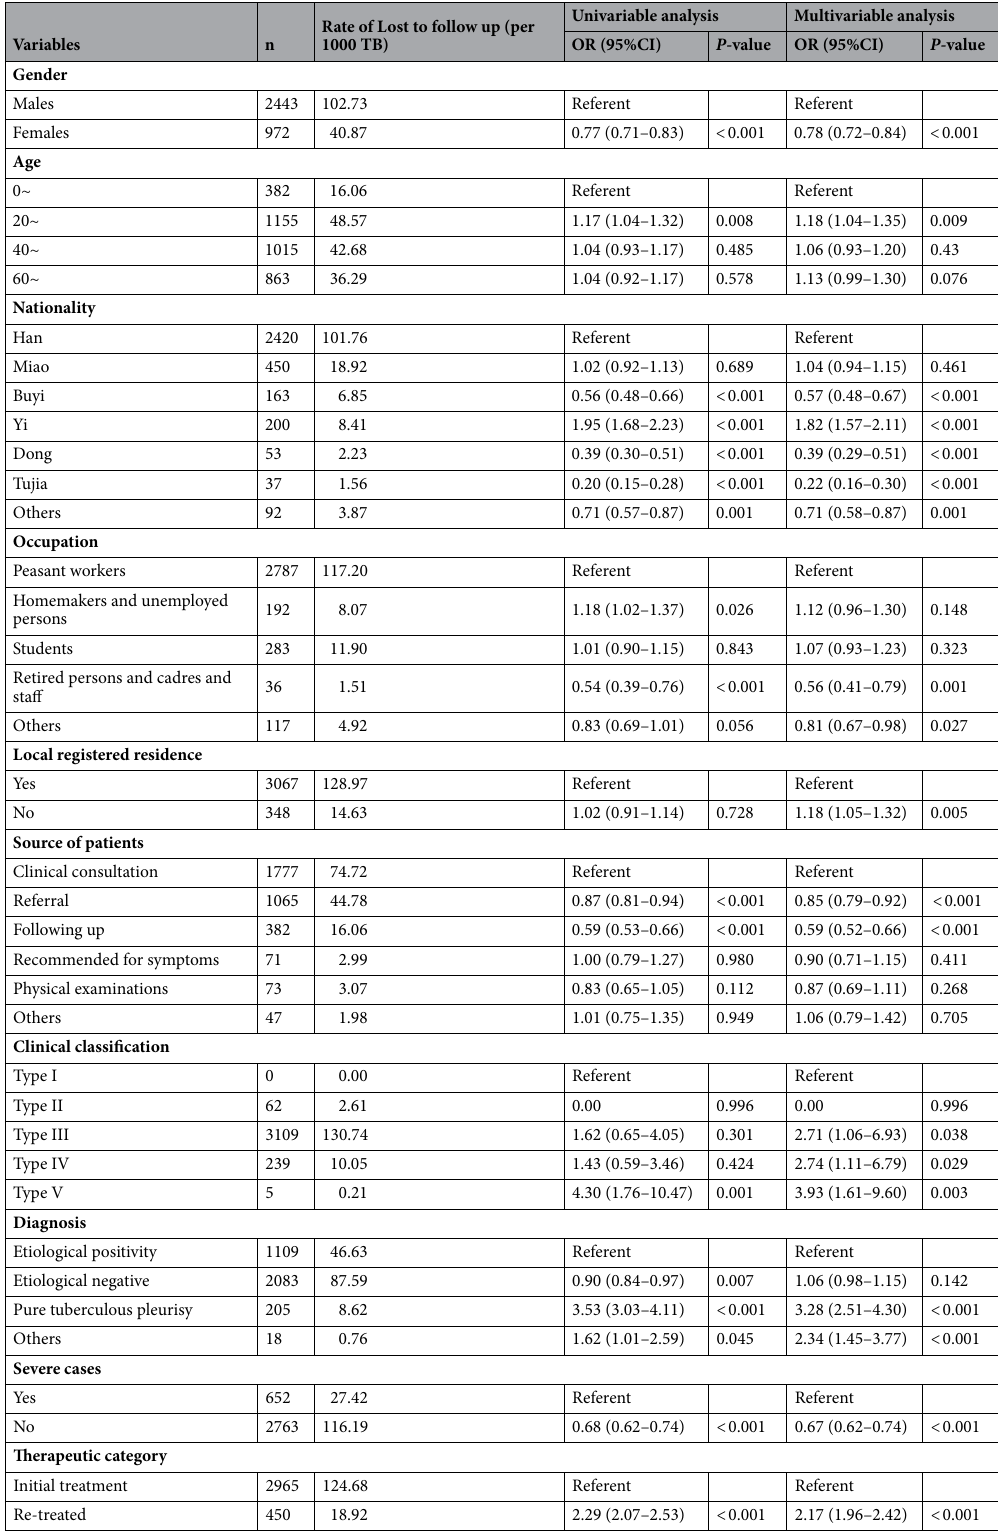
Table 2. Results of risk factors analysis of lost to follow up in TB